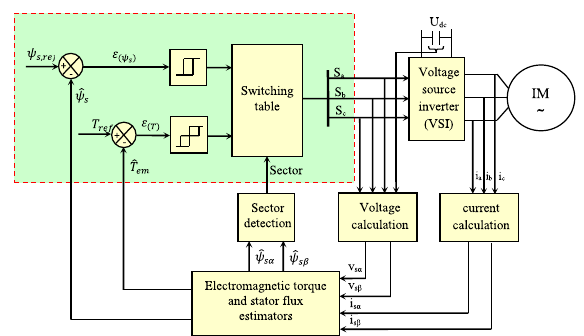
Fig. 1 Synoptic schema of DTC control of the induction